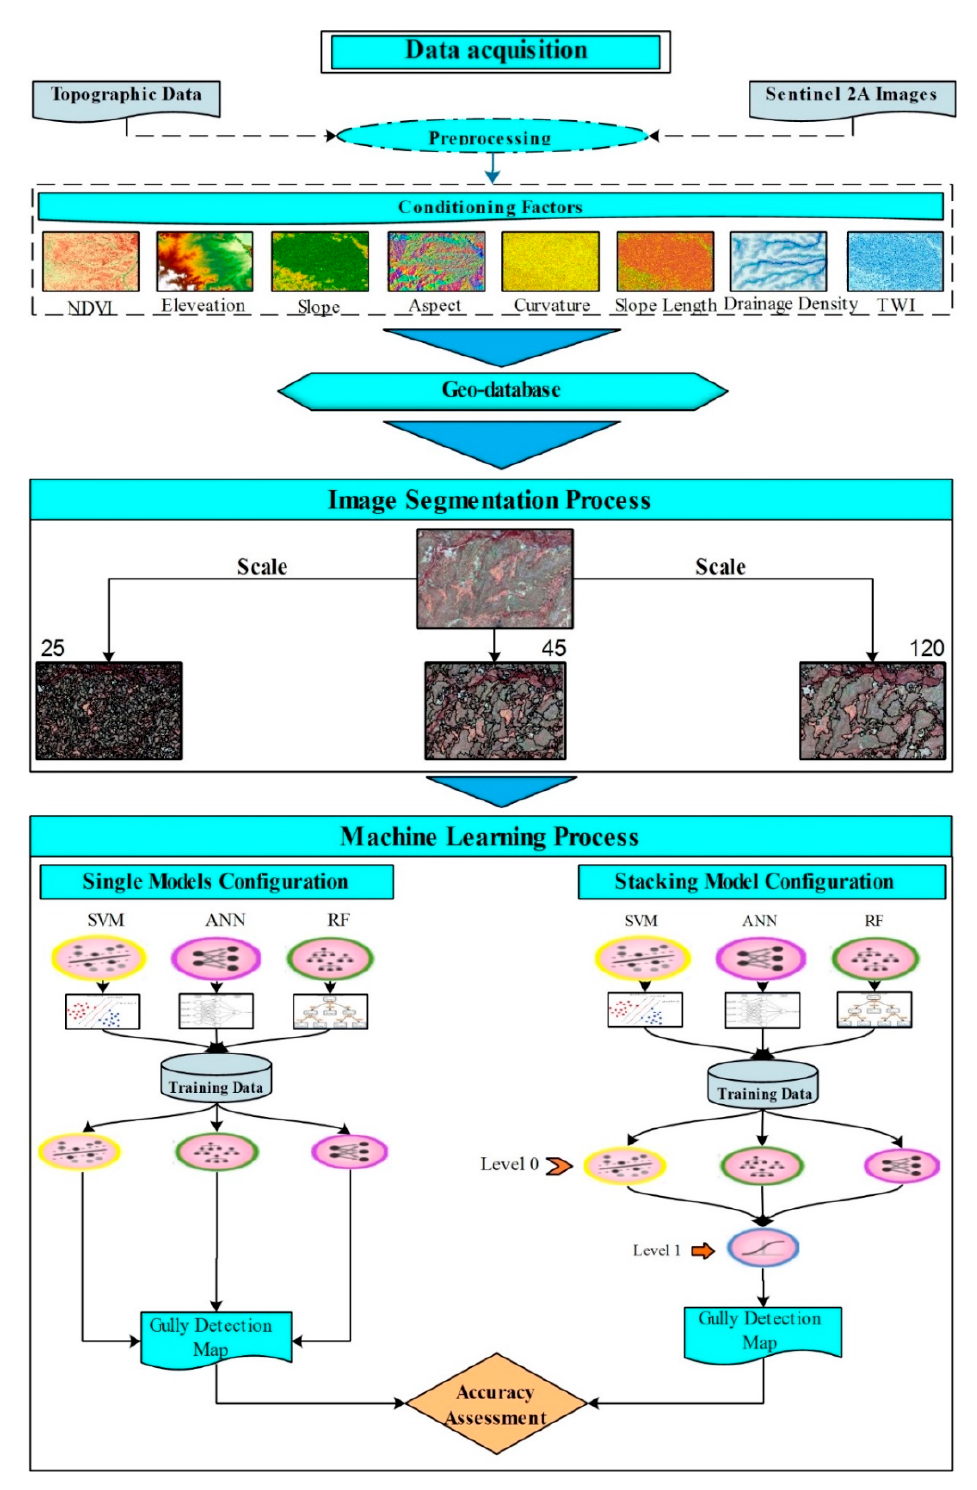
Figure 2. Flowchart of the methodology used in the current study.